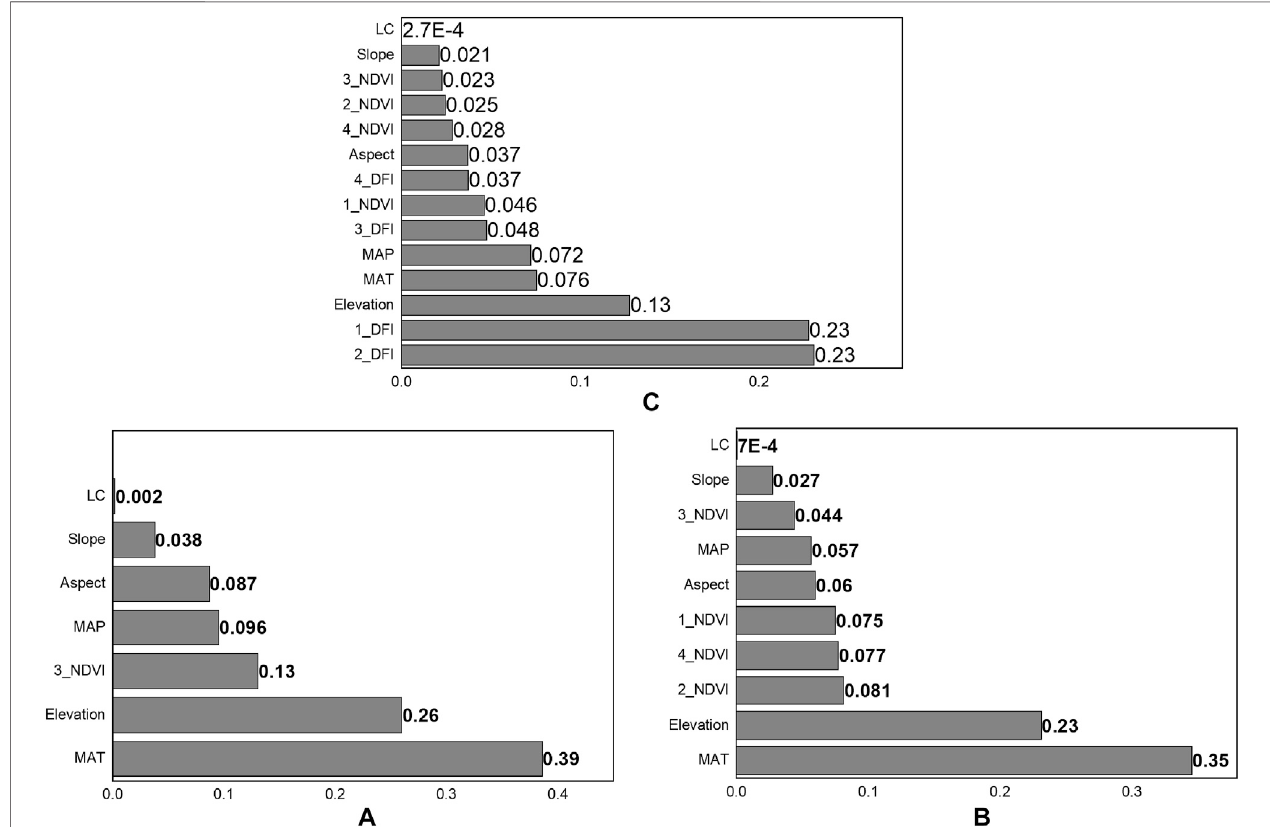
FIGURE 5 | Importance of environmental variables in three models. (A – C) means covariate set A, B, C. 1_NDVI: Normalized difference vegetation index (NDVI) in the fi rstquarter;2_NDVI:NDVIinthesecondquarter;3_NDVI:NDVIinthethirdquarter;4_NDVI:NDVIinthefourthquarter;1_DFI:Deadfuelindex(DFI)inthe fi rstquarter;